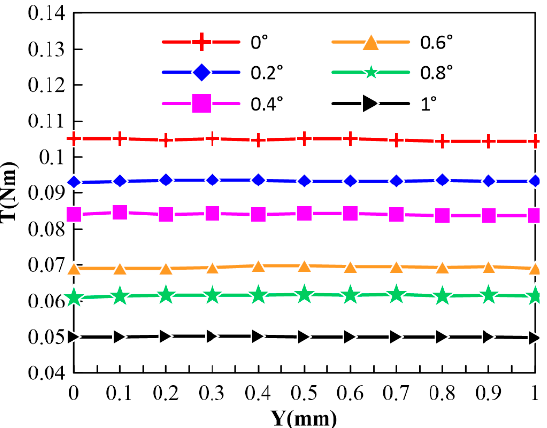
Figure 27. Diagram of the effect of axial displacement on the output electromagnetic torque.